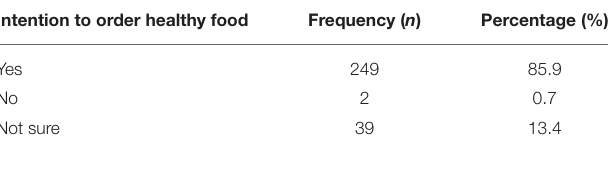
TABLE 8 | Subjects’ intentions to order healthy food via OFD apps in the future.